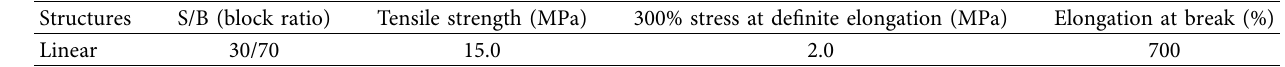
Table 2: Physical properties of the SBS copolymer.